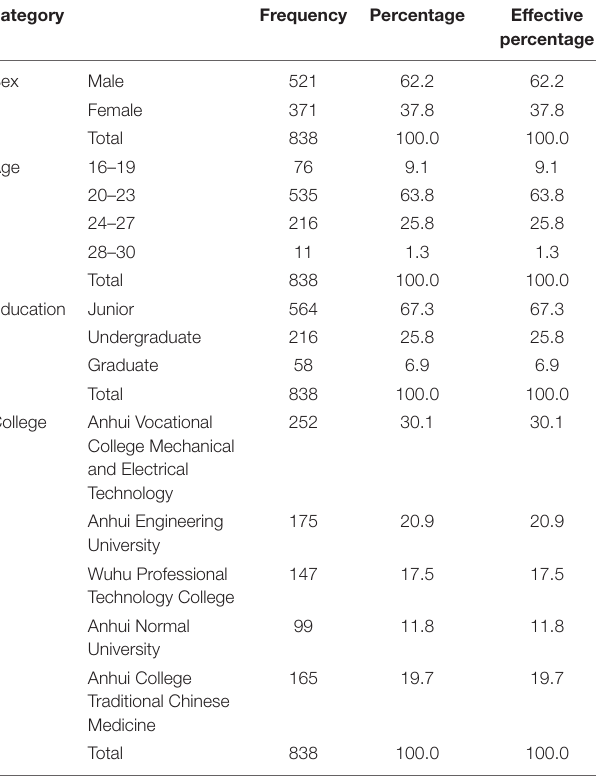
TABLE 1 | Hypotheses of college students’ entrepreneurial intention—behavior extended